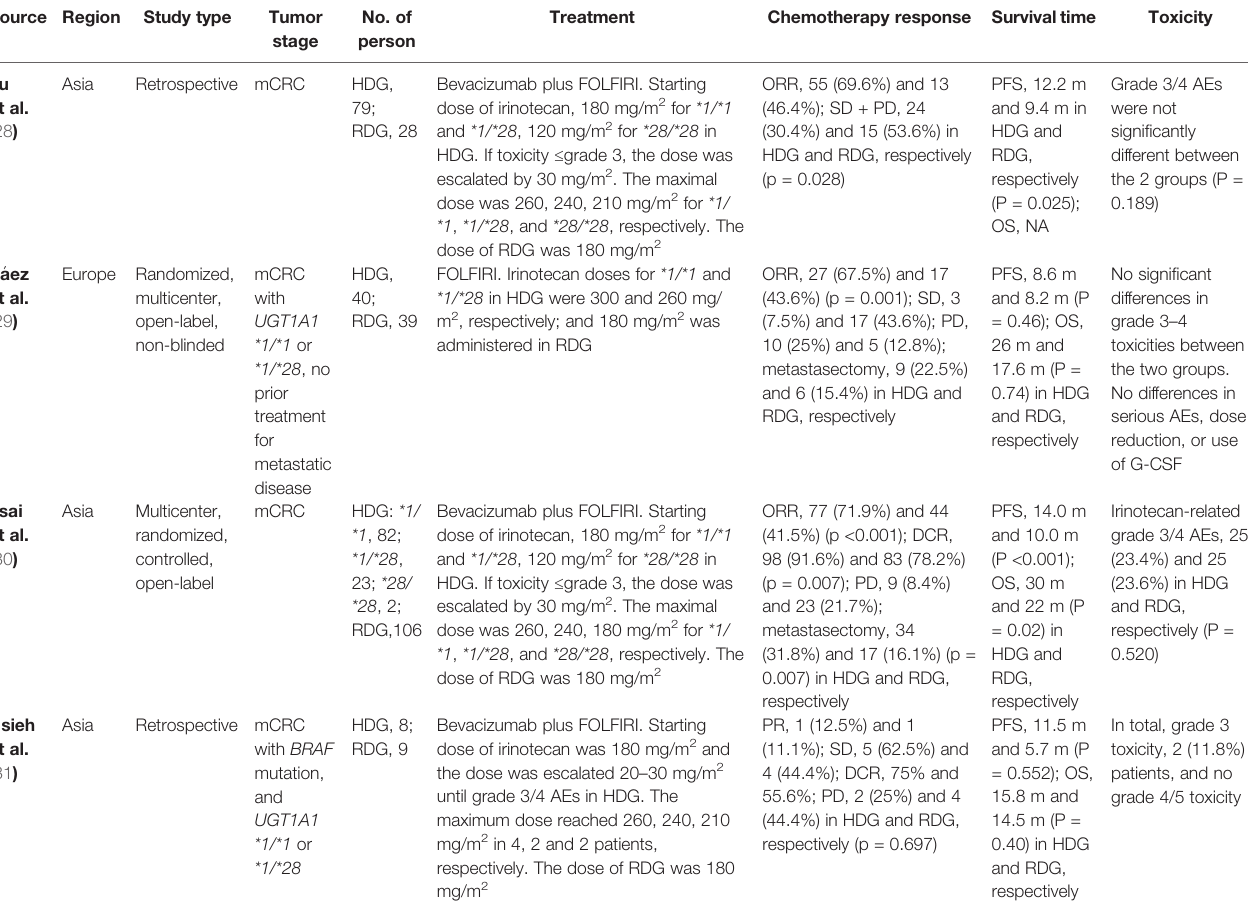
TABLE 3 | Double-arm Trials of High dose Irinotecan based Regimen in